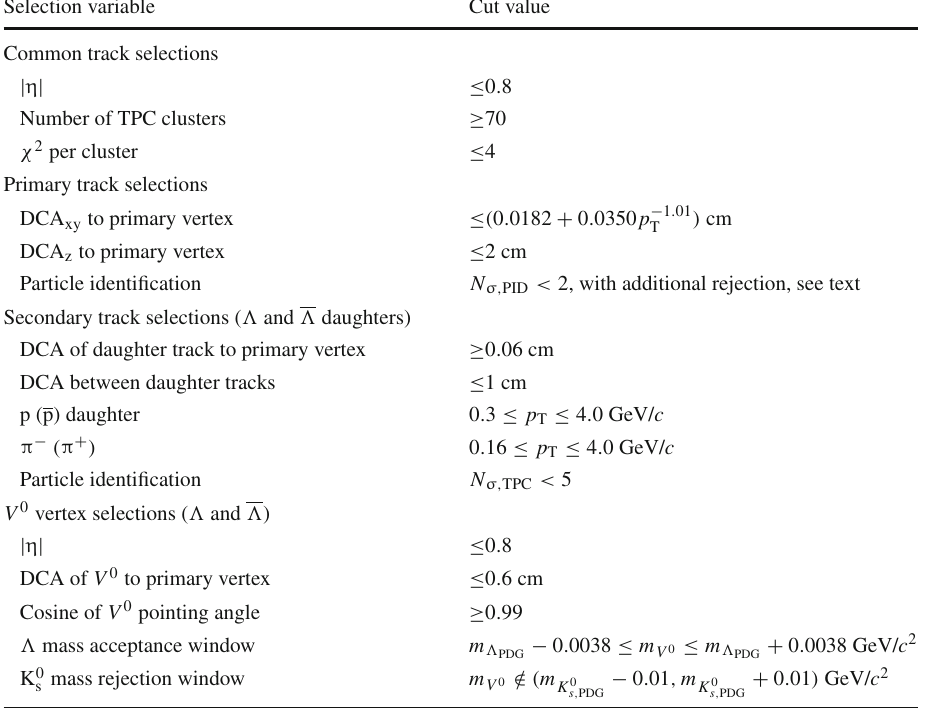
vertex selection